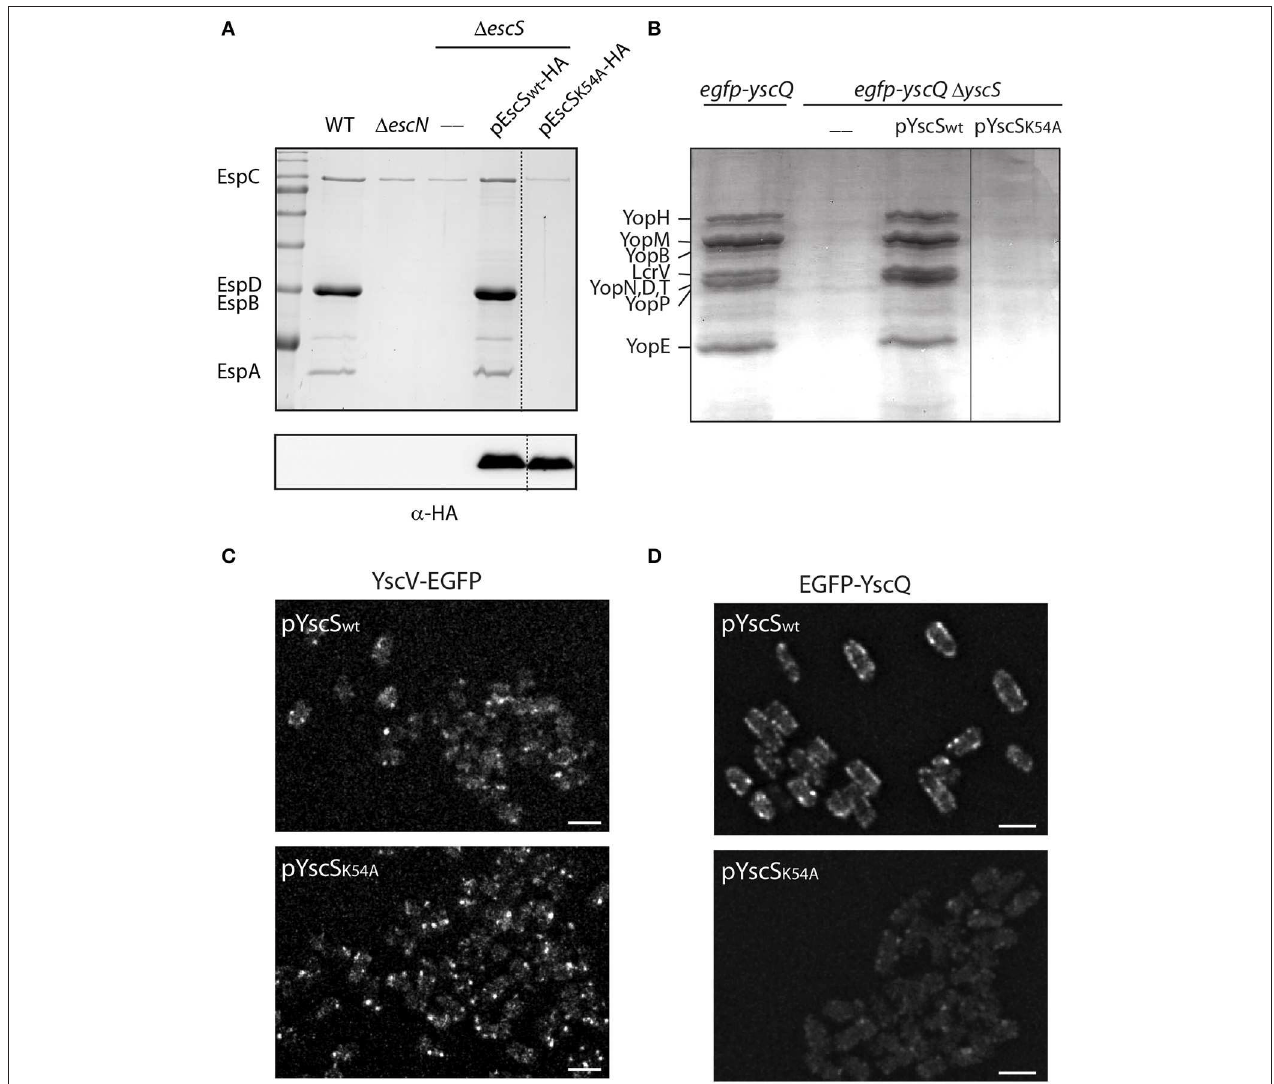
FIGURE 8 | Point mutation at TMD2 disrupts oligomerization of the T3SS cytoplasmic ring. (A) Protein secretion profiles of EPEC WT, 1 escN , 1 escS , and 1 escS carrying the pEscS wt -HA or pEscS K54A -HA grown under T3SS-inducing conditions. The secreted fractions were concentrated from the supernatants of bacterial cultures and analyzed by SDS-PAGE and Coomassie blue staining. The T3SS-secreted translocators EspA, EspB, and EspD are marked on the left of the gel. Also indicated is the location of EspC, which is not secreted via the T3SS. The 1 escS strain carrying the plasmid encoding EscS wt -HA showed proper T3SS activity, while the plasmid encoding EscS K54A -HA was unable to complement T3SS activity. Proper expression of EscS wt -HA and EscS K54A -HA was detected by analyzing bacterial pellets on SDS-PAGE and western blot analysis with an anti-HA antibody. (B) Protein secretion profiles of EGFP-YscQ-expressing WT, 1 yscS or 1 yscS Yersinia strains carrying pYscS wt or pYscS K54A . The secreted fractions were concentrated from the supernatants of bacterial cultures grown under secretion-permissive conditions and analyzed by SDS-PAGE and Coomassie blue staining. Various T3SS-secreted proteins are marked on the left of the gel. (C,D) YscV-EGFP (C) and EGFP-YscQ (D) foci in Y. enterocolitica lacking the yscS gene and expressing either YscS wt or YscS K54A from a plasmid. All images within an experiment were processed using the same settings. Scale bar: 2 µ m.